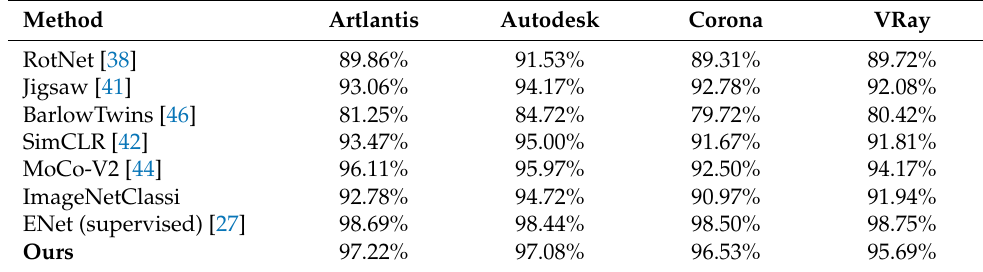
Table 3. Test accuracy of different methods under the fine-tuning evaluation protocol where the fine-tuning was conducted on the whole training set of CG forensics datasets. The presented results are classification accuracies on the testing set of the Artlantis, Autodesk, Corona and VRay datasets.